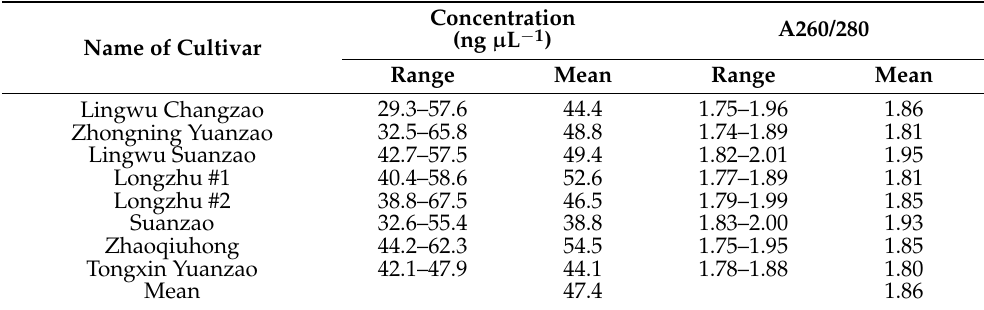
Table 3. Concentration and quality of DNA samples extracted from the pulp tissue of fresh and dried jujube fruits.